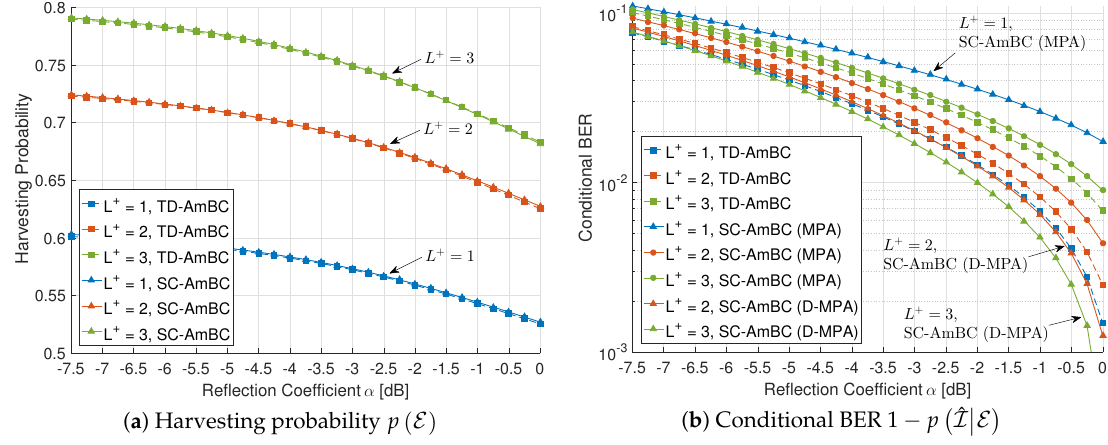
Figure 9. Effect of the number of multipath L + ( M = 4, K = 4, λ = 1.5 for